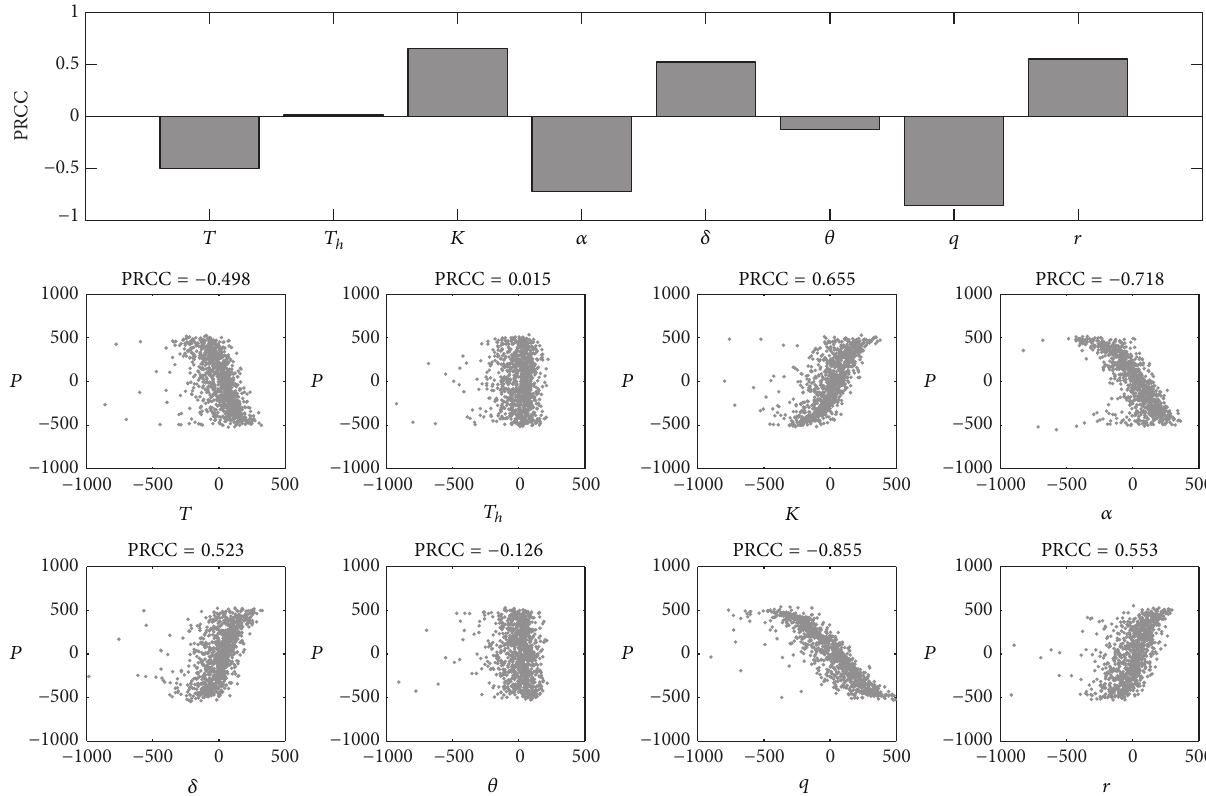
Figure 14: Sensitivity analyses based on the PRCC values for the parasitoid population at 1000th generation. The baseline parameter values are as follows: 𝑇 = 10 , 𝑇 ℎ = 0.5 , 𝐾 = 50 , 𝛼 = 0.005 , 𝛾 = 1 , 𝛿 = 0.5 , 𝜃 = 1 , 𝑞 = 0.2 , and 𝑟 = 2.8